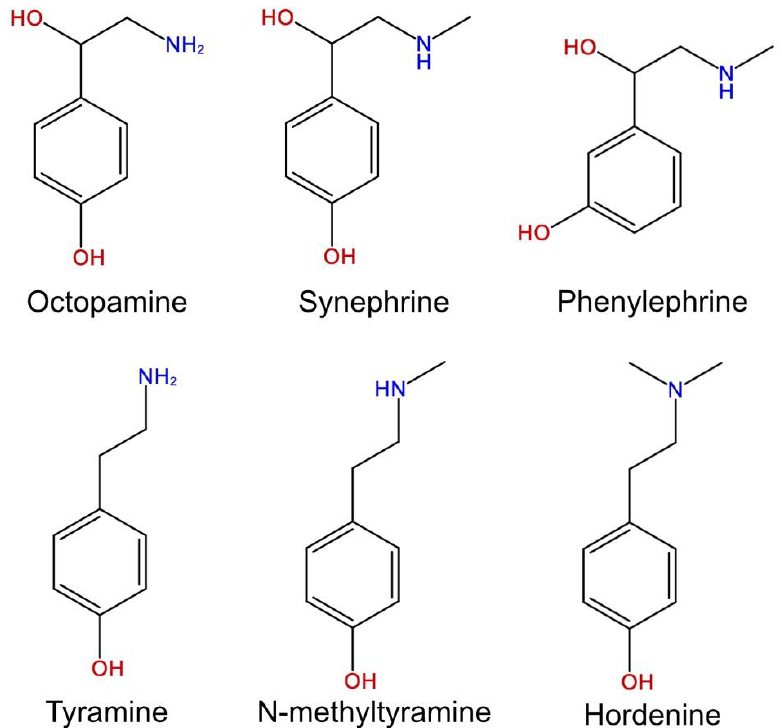
Figure 2. Active amines of Citrus aurantium L. regulated for their content in food supplements.